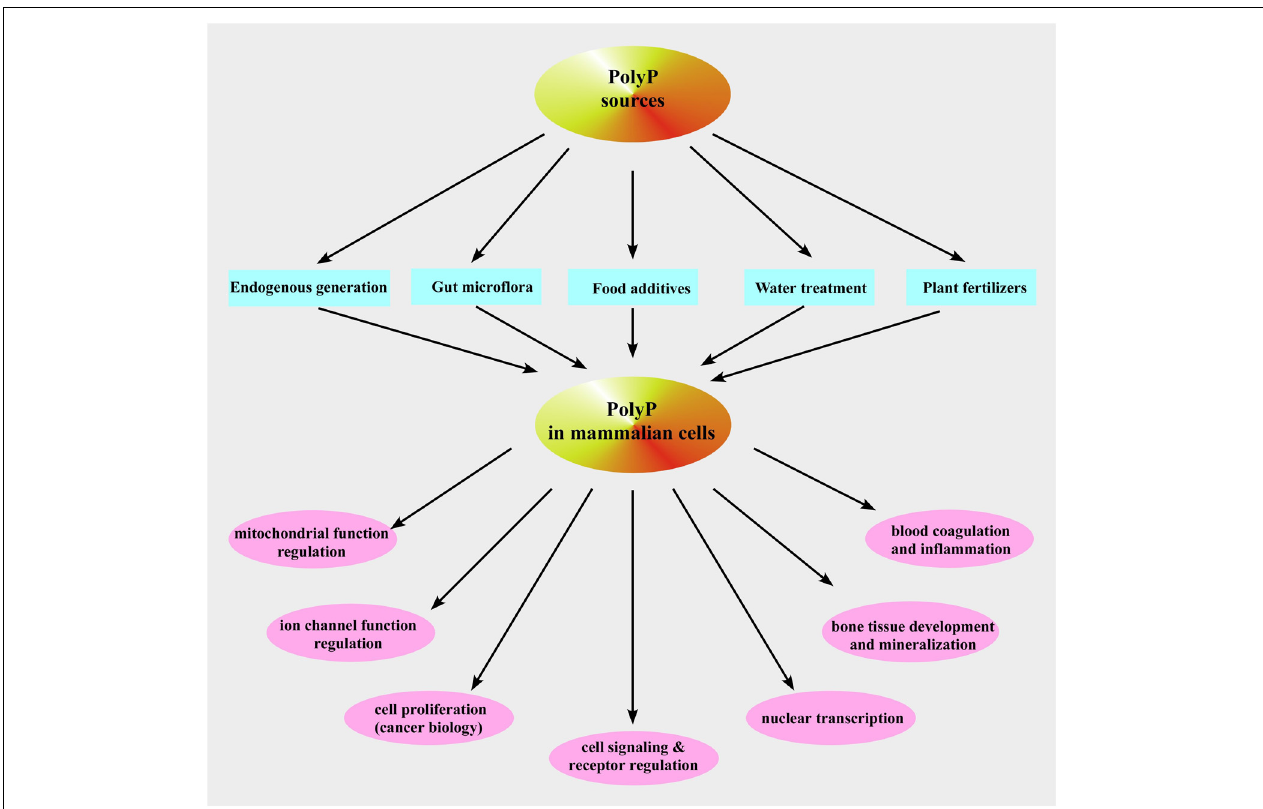
FIGURE 4 | Inorganic polyphosphate sources and functions in mammalian cells. Shown is a schematic representation of the described pathways of polyP occurrence and functions in mammalian